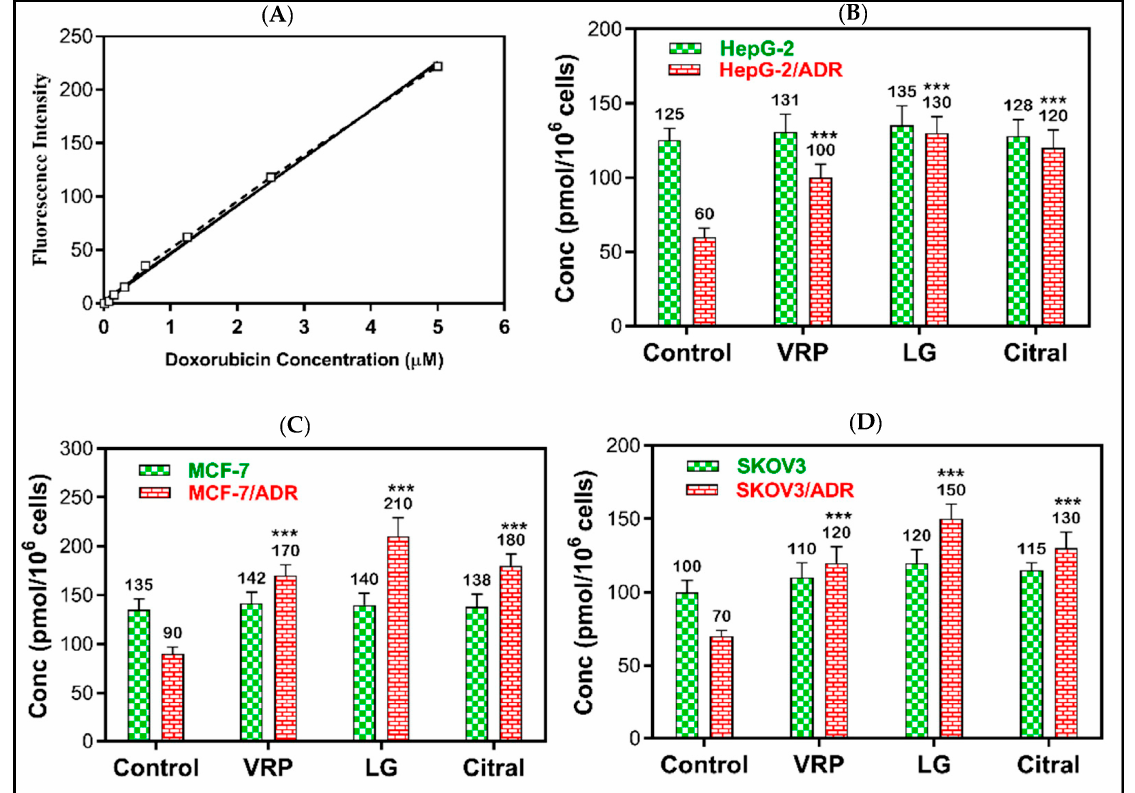
Figure 4. The effect of LG and citral on doxorubicin accumulation in resistant cells. The mean of the fluorescence intensity of DOX plotted against its concentration in the standard curve ( A ), the mean of cellular DOX levels (pmol/106 cells) computed from the standard curve in ( B ) HepG-2 and HepG-2/ADR, ( C ) MCF-7 and MCF-7/ADR, and ( D ) SKOV3 and SKOV3/ADR. *** p < 0.001 compared to untreated. Verapamil (10 µM) was used as the positive control.